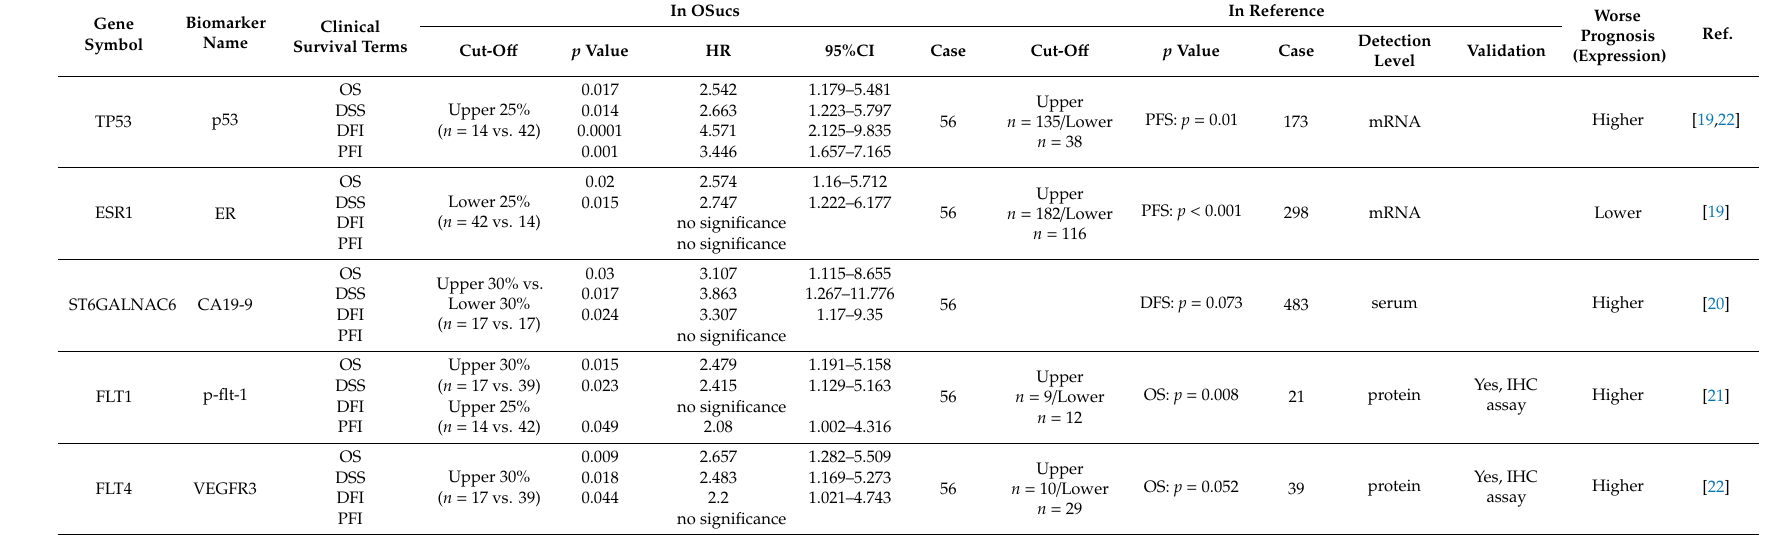
Table 2. Verification of previous published predictors for UCS / uterine cancer (UC) survival in